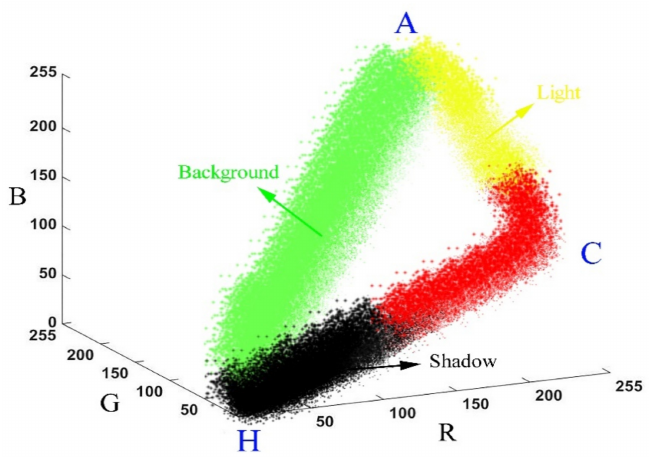
Figure 3. Pixel distribution area of apples and the shadows and halation on the